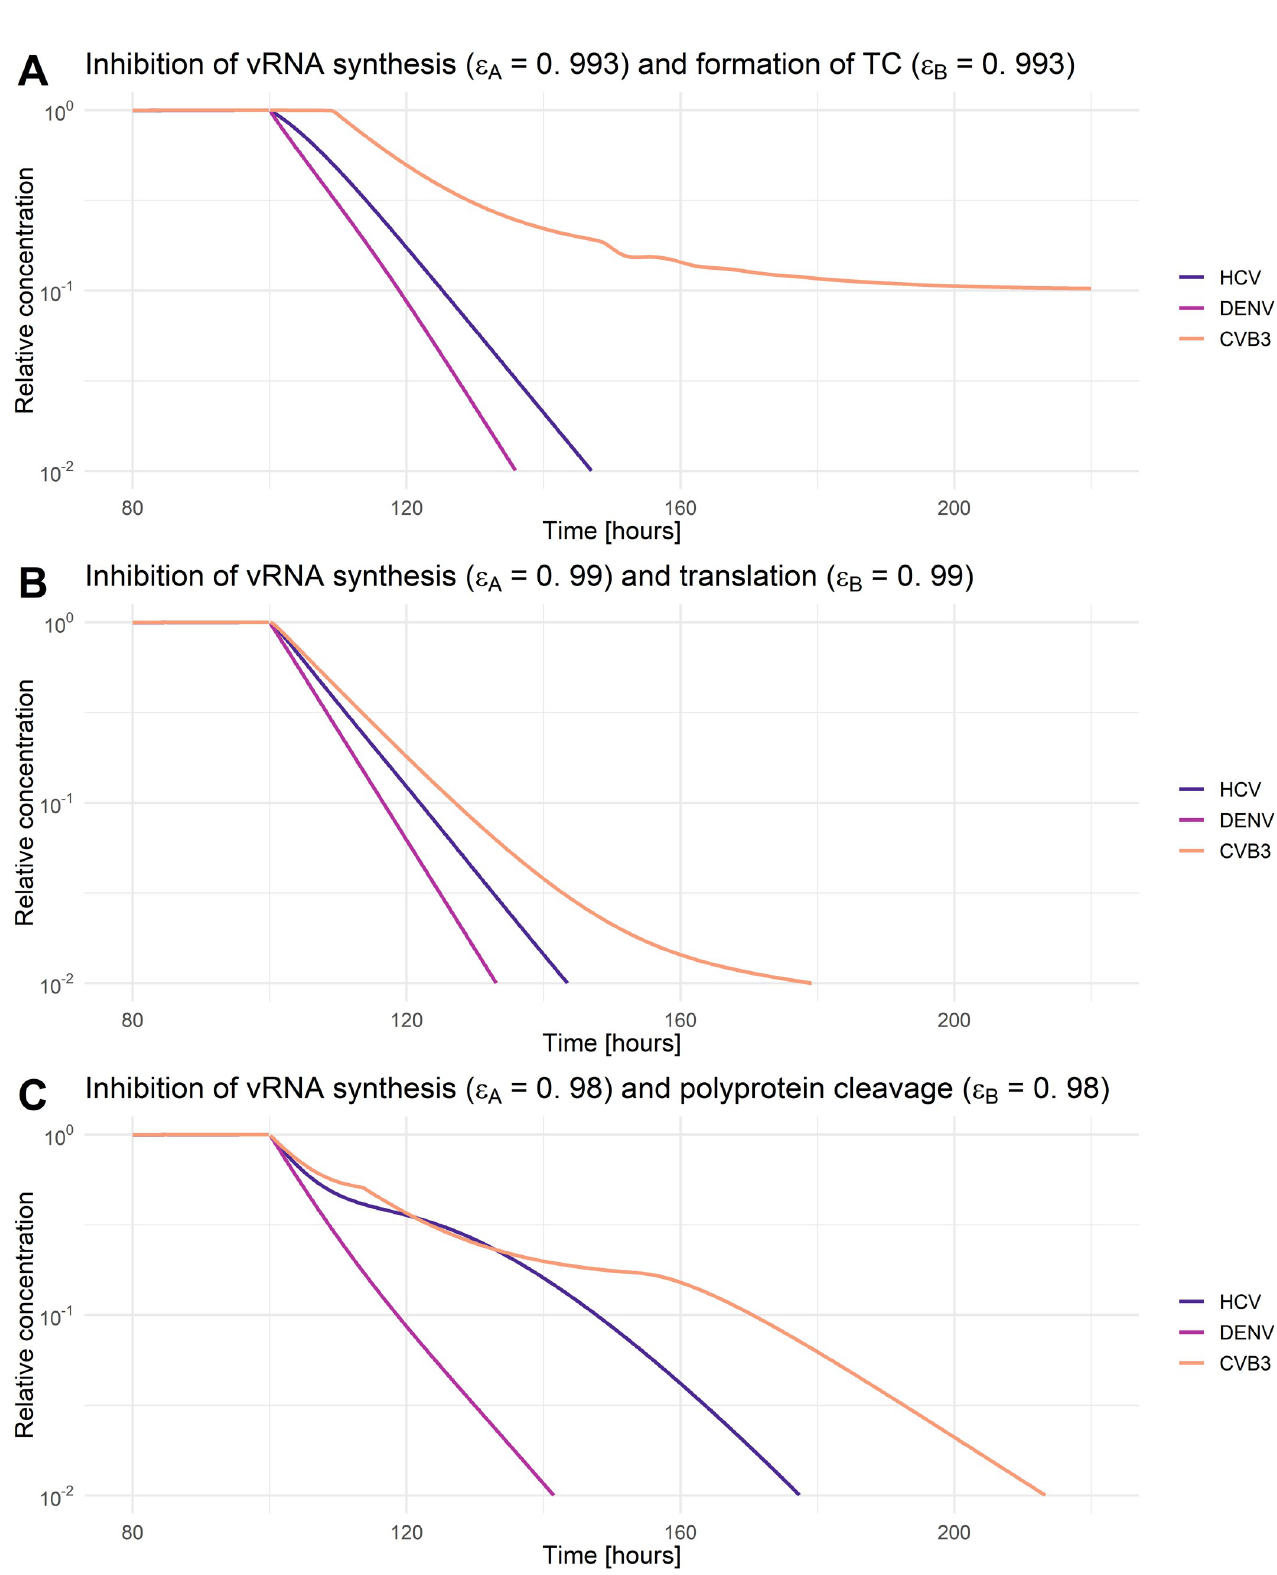
Fig 9. Relative virus decay under combination therapy that clears HCV, DENV, and CVB3 infections. A combined drug effect on A) vRNA synthesis and formation of translation complex (TC), B) vRNA synthesis and translation, and C) viral RNA synthesis and polyprotein cleavage. Initiation of treatment was